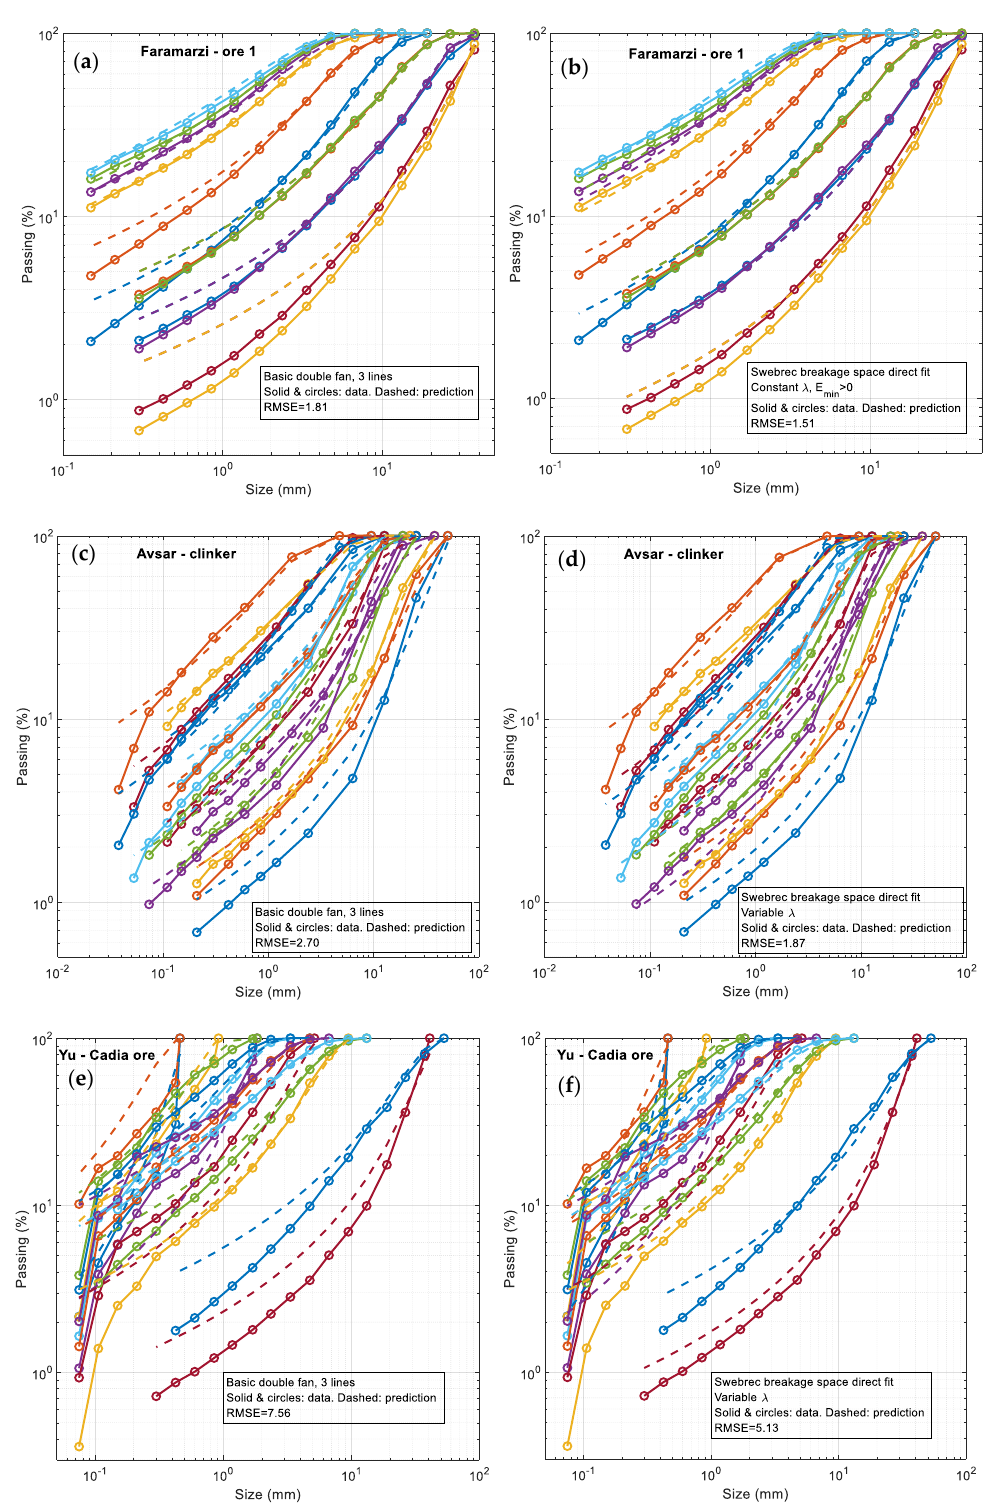
Figure A10. Assessment of the model replication of the raw size distribution data. ( a , c , e ) basic double fan fit. ( b , d , f ) direct Swebrec fit. ( a , b ) Faramarzi’s [27] ore 1; ( c , d ) Avsar’s [23] clinker (for clarity, only half of the curves have been plotted) and ( e , f ) Yu’s [26] Cadia ore (for clarity, only a quarter of the curves have been plotted).